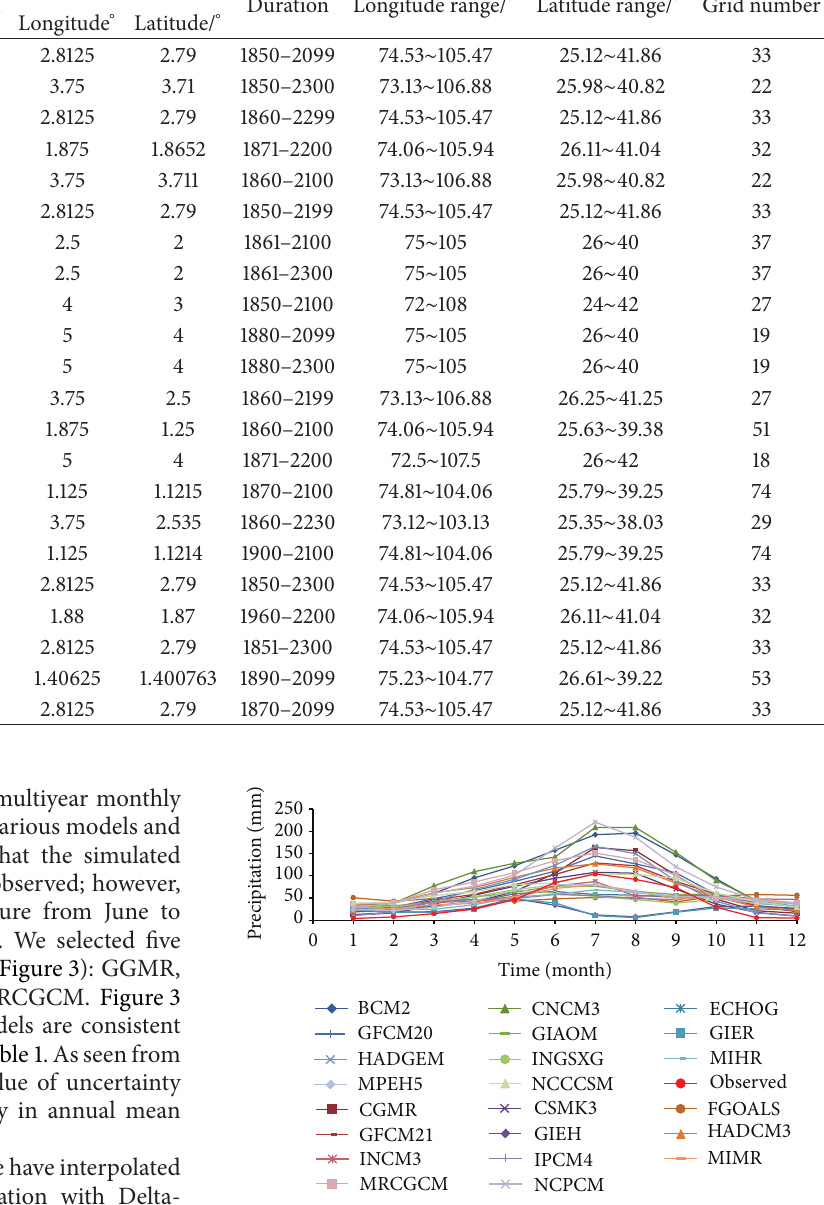
Figure 2: Comparison of annual temperatures (1961 ∼ 1990) on the Tibetan Plateau between simulation and